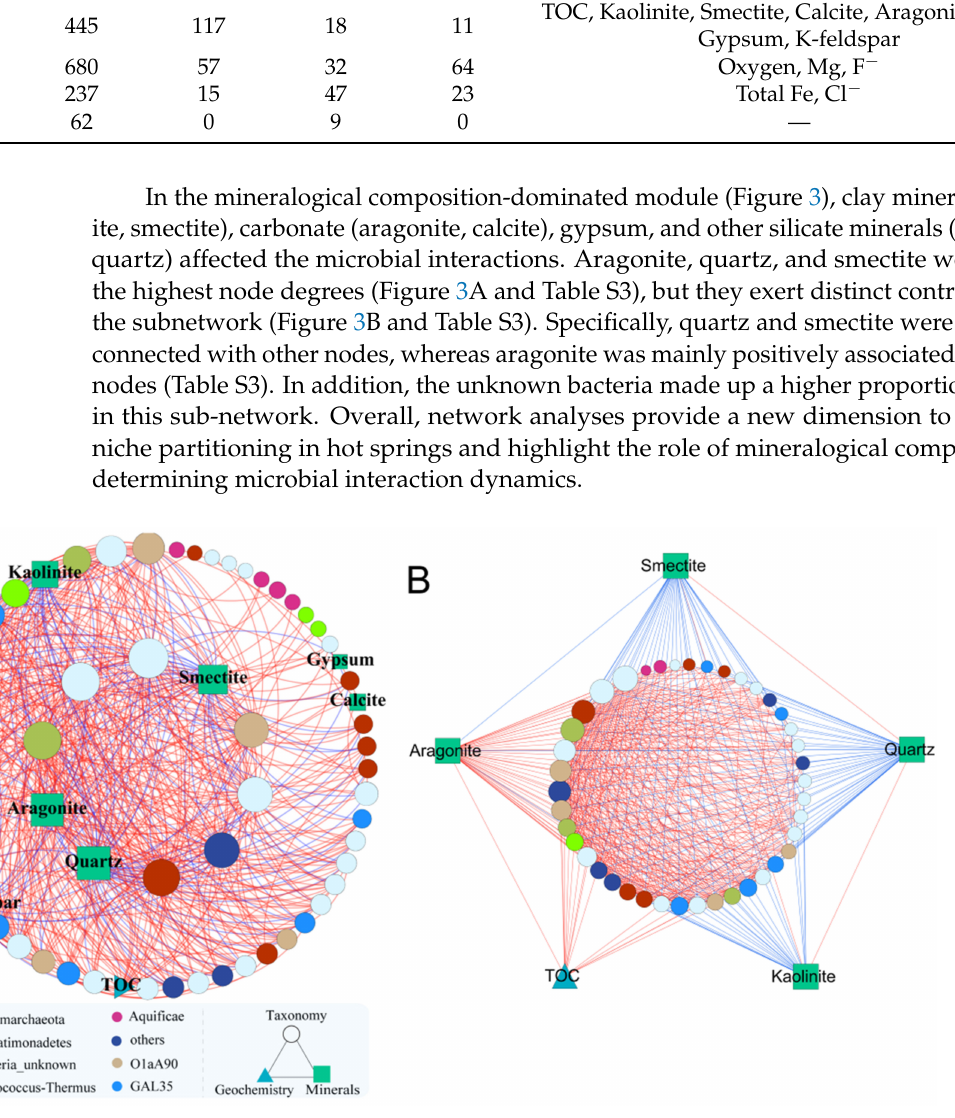
Figure 3. The sub-networks highlighting the influence of the minerals on species interactions. ( A ) This subnetwork represents the module 3 extracted from Figure 2. The nodes in the inner circle were among the top 10 nodes ranked by degree. Nodes were arranged counter-clock-wise for inner and outer circles, respectively. ( B ) A subnetwork for aragonite and its first neighbors in module 3. The size of nodes is proportional to the number of degrees. Blue and red edges indicate negative and positive interactions between nodes, respectively. Different colors for circular nodes represent different taxa at the phylum level (class for